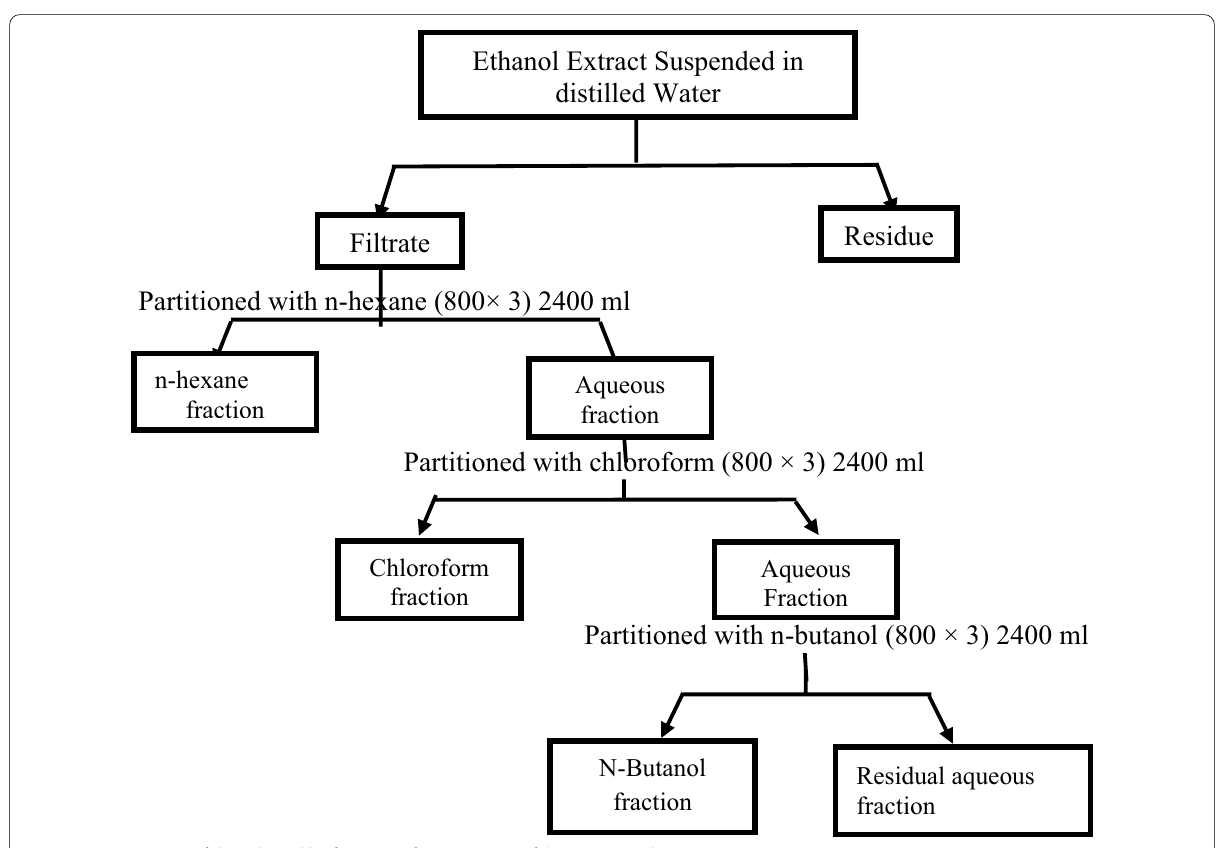
Fig. 1 Fractionation of the ethanol leaf extract of Ipomoea asarifolia (Deng et al.